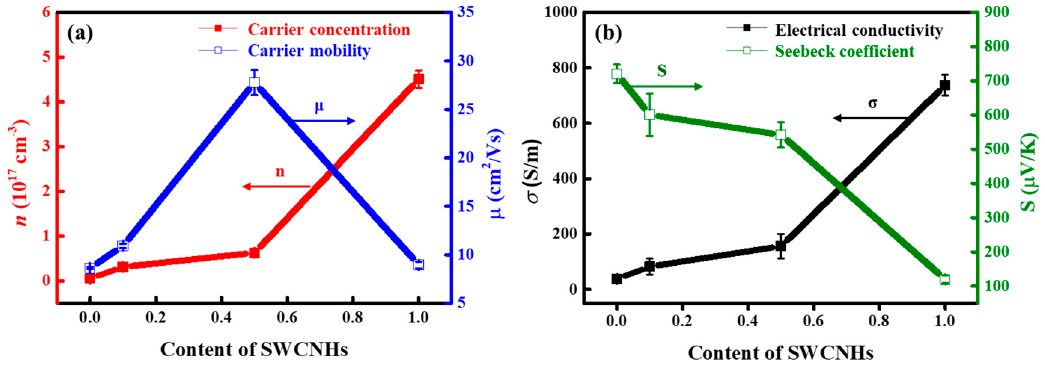
Figure 6. ( a ) Carrier concentration and carrier mobility plots. ( b ) Electrical conductivity and Seebeck coefficient of the WS 2 /SWCNH nanocomposites with the content of SWCNHs.